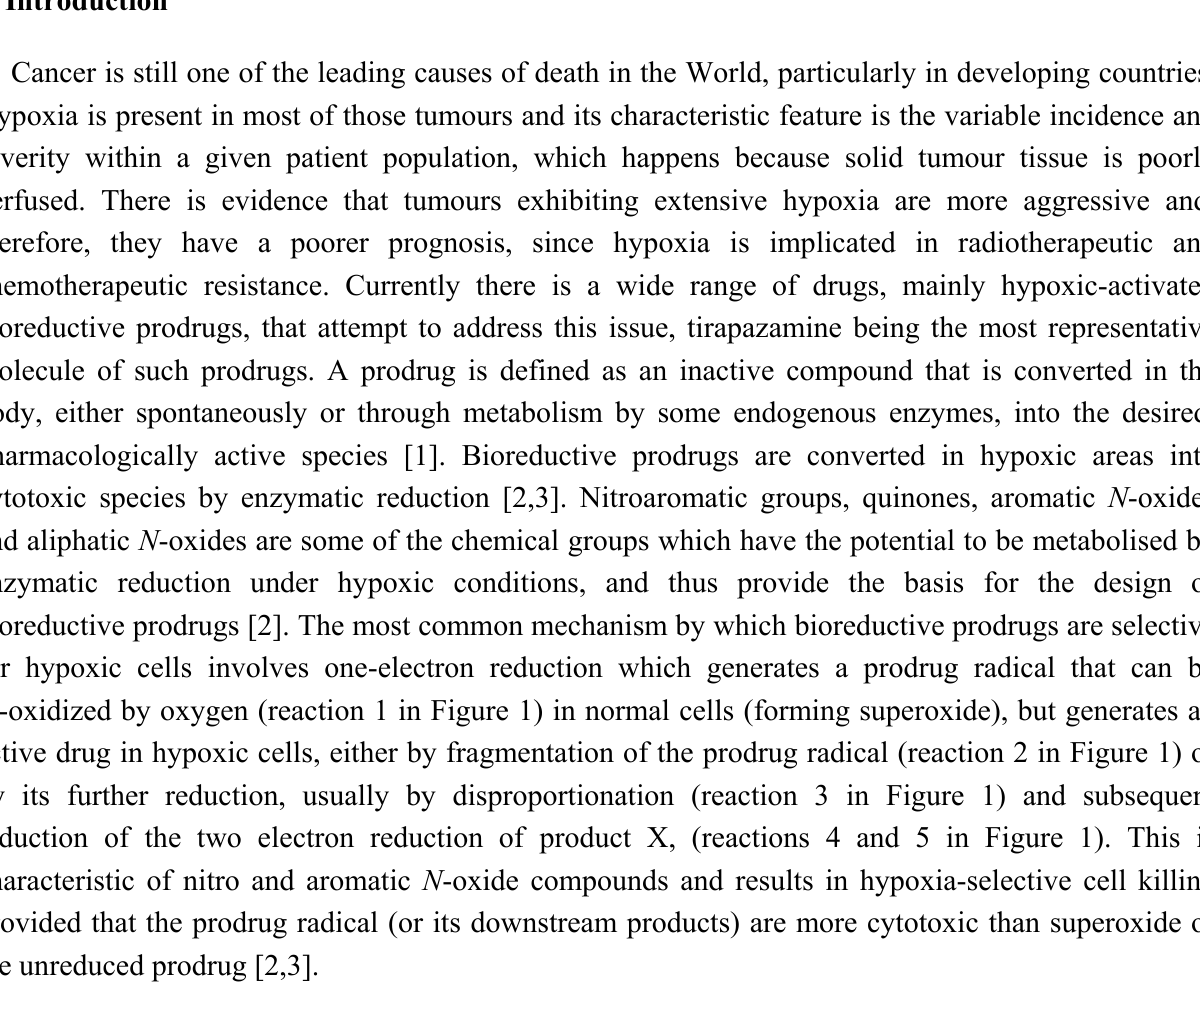
Figure 1. One-electron versus two-electron reduction of bioreductive prodrug